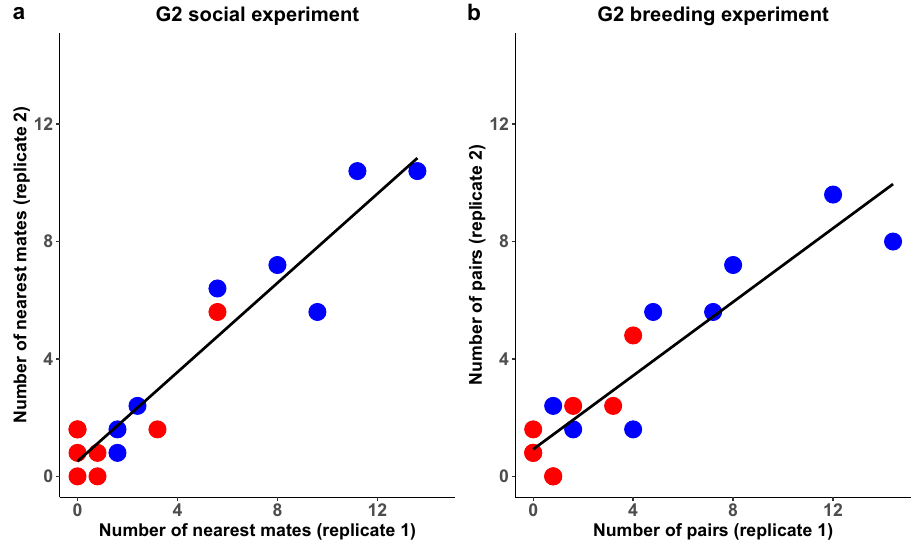
Fig. 5 Repeatability of pairing behaviour between replicates. Shown are the number of associations for each of the 16 possible pair categories (each dot refers to one category, e.g., DD-DW, see Figs. 3 and 4). Blue dots refer to pair combinations that share the same song dialect, while red dots represent disassortative pairings with regard to song. a Pairings de fi ned as the nearest individual of the opposite sex (distances averaged across 118 million observations over a period of 30 days, n = 151 pairs) in replicates 1 versus 2 (Pearson r = 0.95, p = 1.3*10 − 8 , two-tailed) in the social experiment with barcode tracking but no nesting opportunities. b Observed pairs during the breeding experiment ( n = 147 pairs) in replicate 1 versus 2 ( r = 0.92, p = 4.7*10 − 7 , traits of the same individual ’ s song (for 16 traits: mean r = 0.16, Hence, it seems highly unlikely that the fi ndings shown in Table 2 range: r = 0.04 - 0.24, n = 413 males) 51 . Second, courtship dance arose from correlations with these other culturally transmitted movements are linked to song elements only in a probabilistic traits, especially because the birds that are being compared have way (i.e., the probability of a movement occurring in a given never met and have no shared foster parents. If such confounds 33 ms time window of a male ’ s song rarely exceeds 30%) 52 . would exist, they would need to be tightly linked to song to